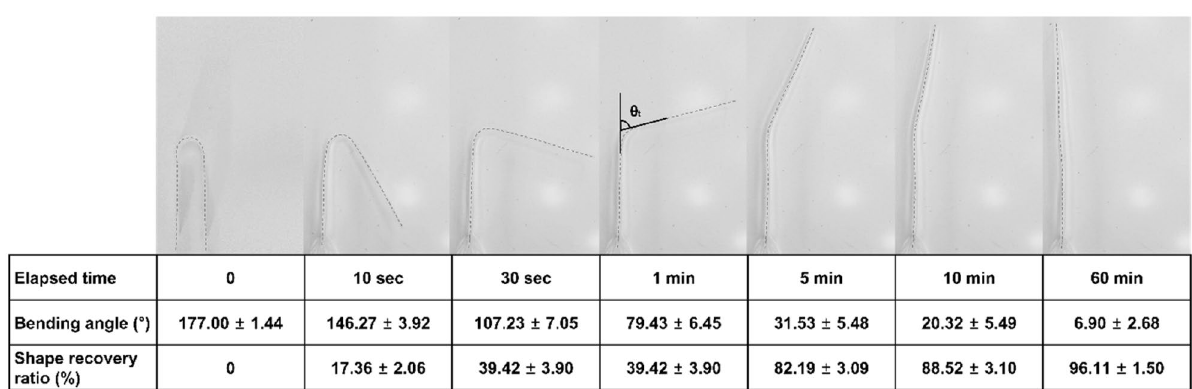
Figure 4. Shape memory effect and shape recovery ratio over time of TC-85 (N =